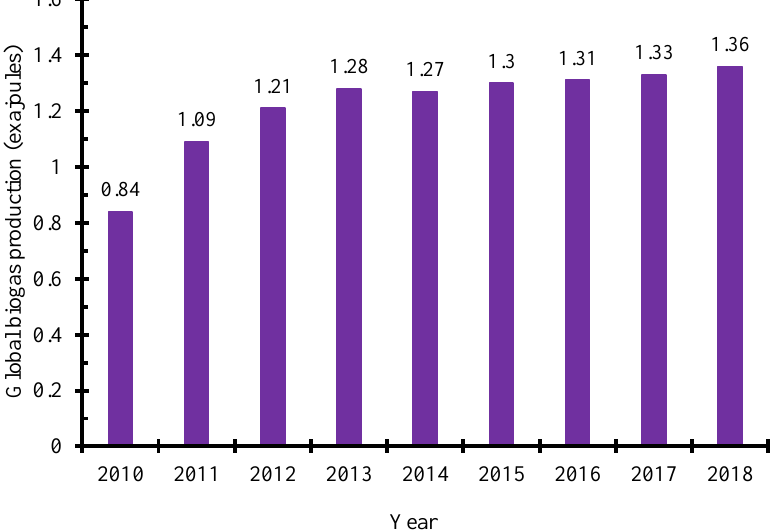
Figure 4. Global biogas production from 2010 to 2018 (exajoules). Adapted by the authors from [40].